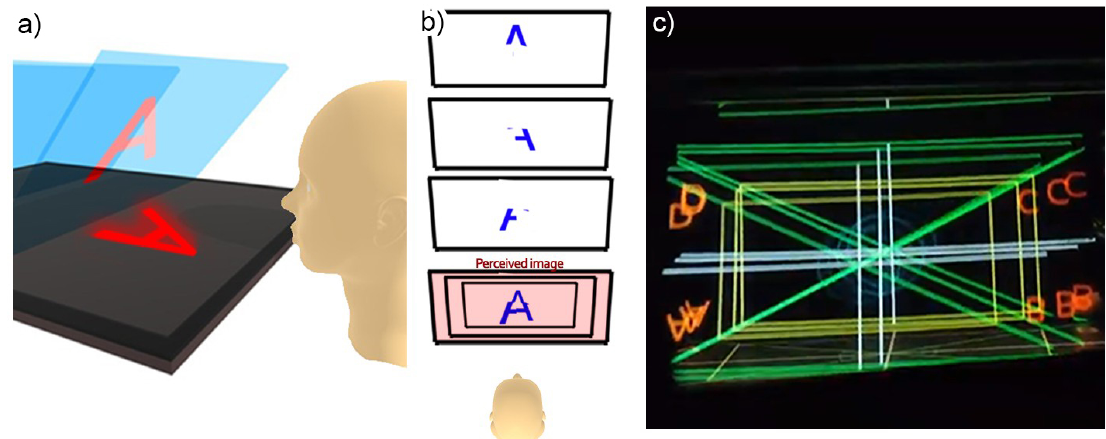
Figure 3. ( a ) Vertical mirroring. ( b ) Size mismatch when no z-based scale correction is applied. ( c ) Calibration templates for three layers.